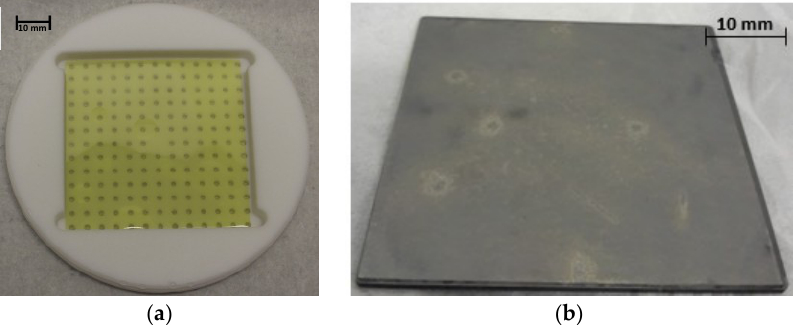
Figure 1. ( a ) Photography of a 52 × 52 mm 2 free-standing cubic silicon carbide (3C-SiC) epitaxial layer after removing the silicon substrate. ( b ) Merged 3C-SiC-on-SiC seeding stack for a two inch process.